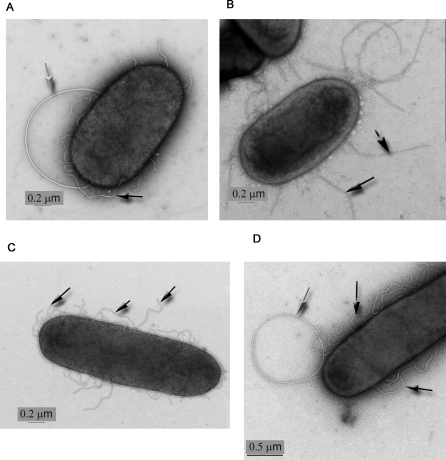
Multi-Drug–Resistant P. aeruginosa Clinical Isolates Display Unusual Appendage-Like Structures on the Cell SurfaceTransmission electron microscopy (TEM) images of MDR virulent clinical isolates at magnification of 15,000 × 1.4.(A) Strain MDR1.(B) Strain MDR13.(C) Strain MDR25.(D) Strain MDR26.Novel appendage-like structures are shown by black arrows. For comparison, flagella are indicated by grey arrows.